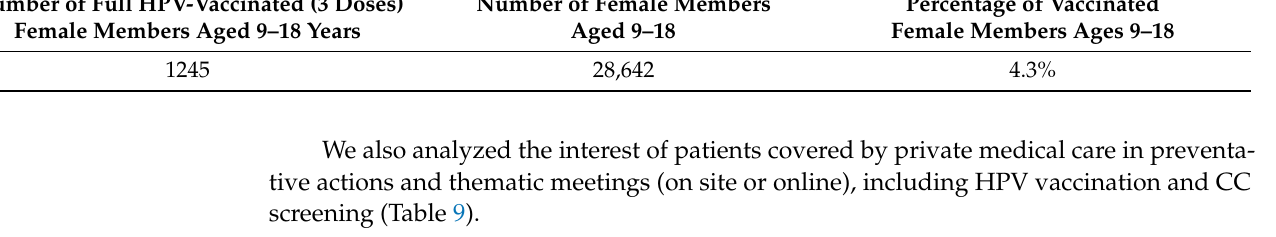
Table 9. Number of participants in preventative actions from 2019 to 2021 (private health care).